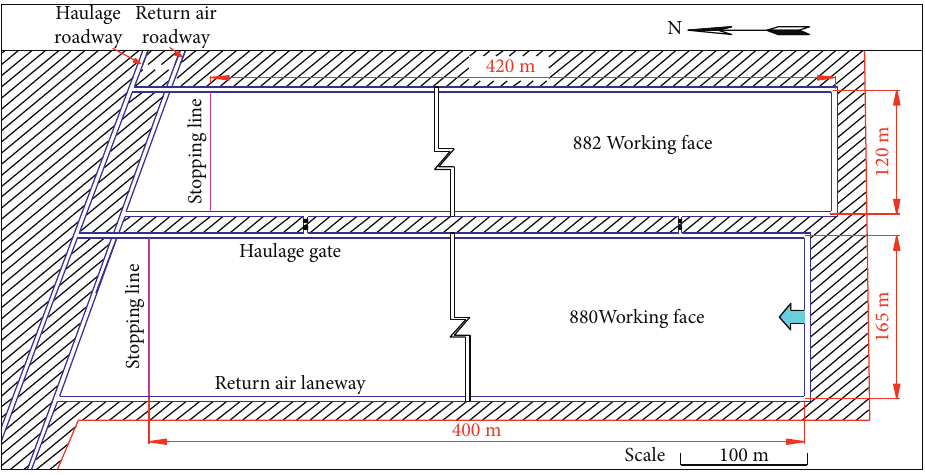
Figure 1: Layout of working face 880 under the